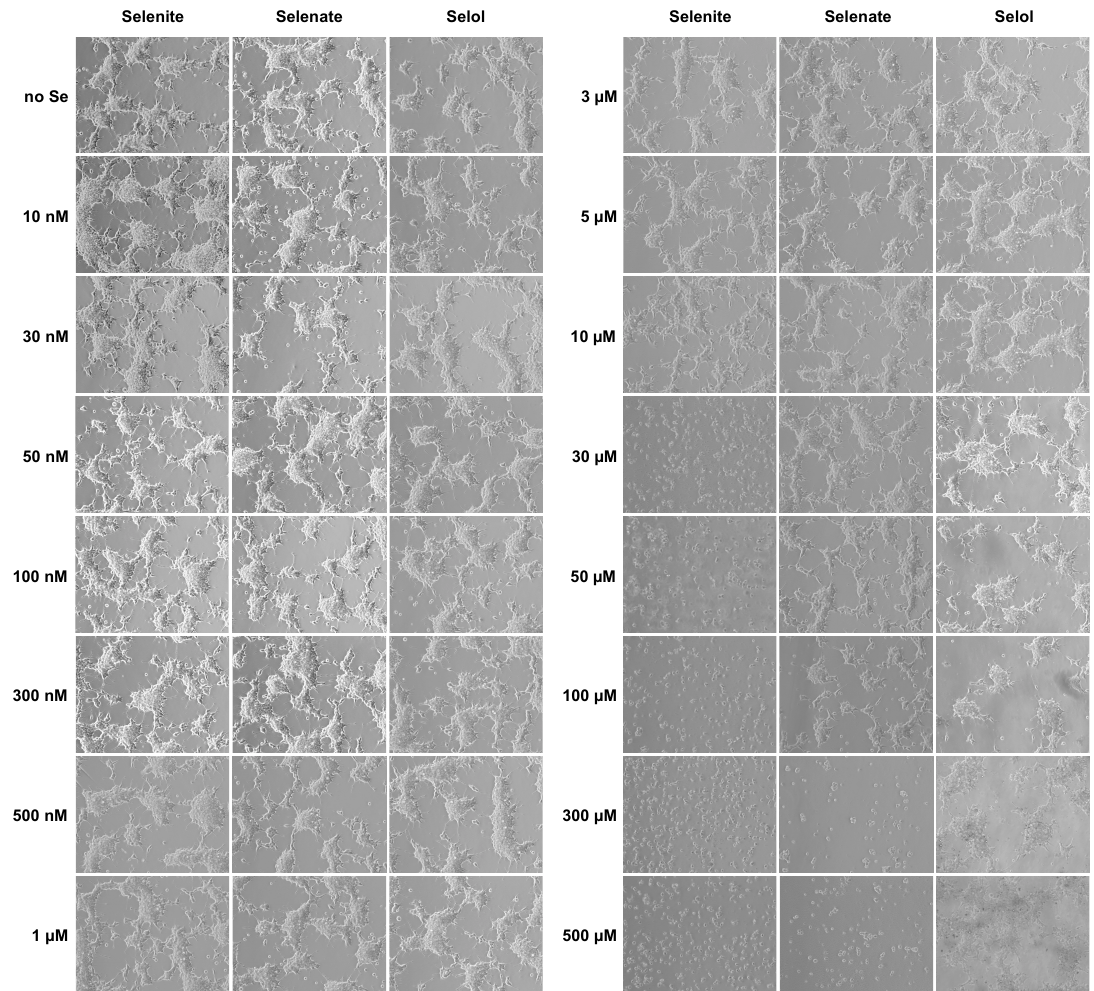
Figure 3. HEK293 morphology in response to various concentrations of three selenocompounds, namely selenite, selenate and Selol. Cells were grown for three days as described in materials and methods. Toxic effect of selenium is visible by cell detachment from the culture dish.